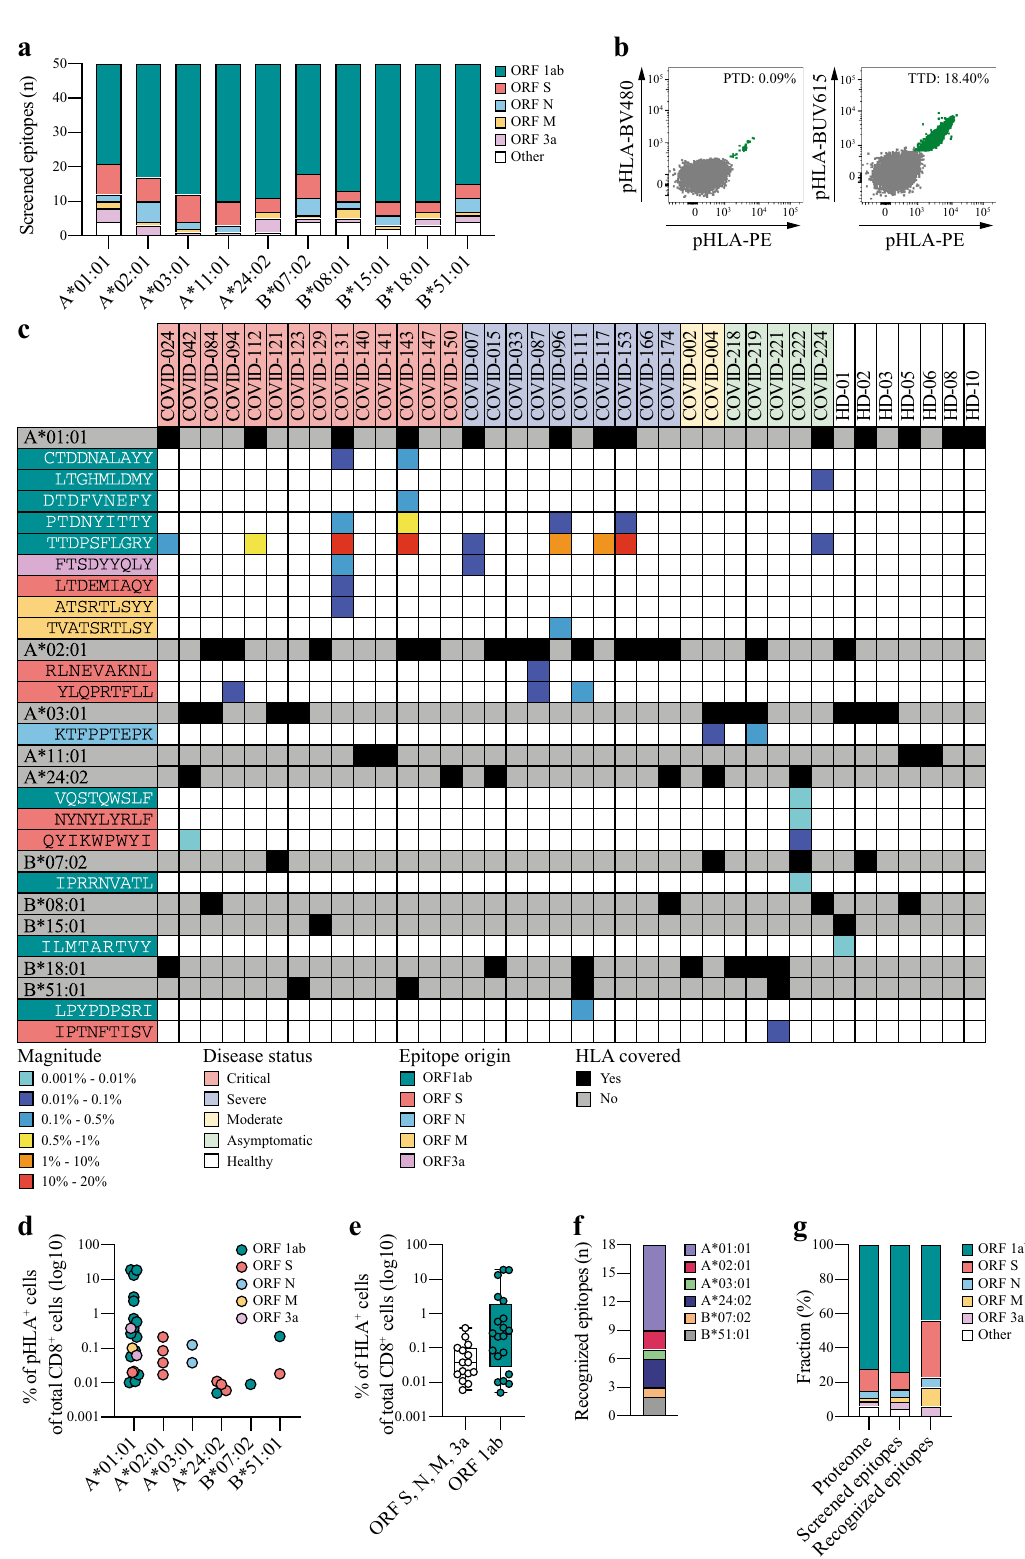
purpose, we obtained information on 385,154 globally isolated SARS-CoV-2 sequences using the COVID-19 CoV Genomics tool 28 . Alternative epitopes with a median SNV frequency of 0.041% (range: 0.01 – 8.44%) have been reported for 17 of the 18 epitopes that were identi fi ed in this study (Supplementary Table 3). Hotspot mutations (SNV frequency cut-off of 2.5% to NATURE COMMUNICATIONS| (2021) 12:2593